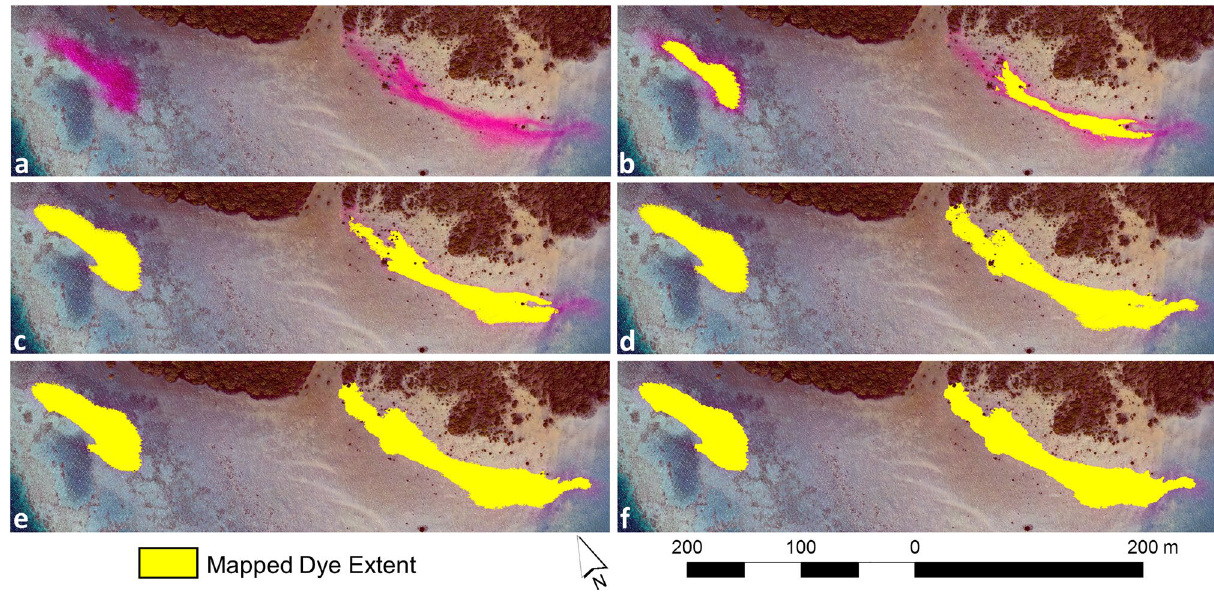
Figure 2. Object-based image classification steps. Orthomosaic of the unmanned aerial vehicle flight survey between 13:37 and 13:53 ( a ) and classification steps of dye plume extent mapped using multi-threshold segmentation ( b ), thresholding of the Red:Blue and Red:Green band ratios ( c ) and the Red:Green band ratio and (Red/Blue) × (Red/Green) interaction term ( d ), gap-filling of unclassified objects enclosed by mapped dye extent ( e ), and smoothing of the object edges ( f ). Software used to produce the maps: Agisoft Metashape version 1.7.1 (www. agiso ft. com), eCognition Developer version 10.1.1 (https:// geosp atial. trimb le. com/ produ cts- and- solut ions/ ecogn ition) and ArcGIS version 10.5.1 (www. esri. com/ en- us/